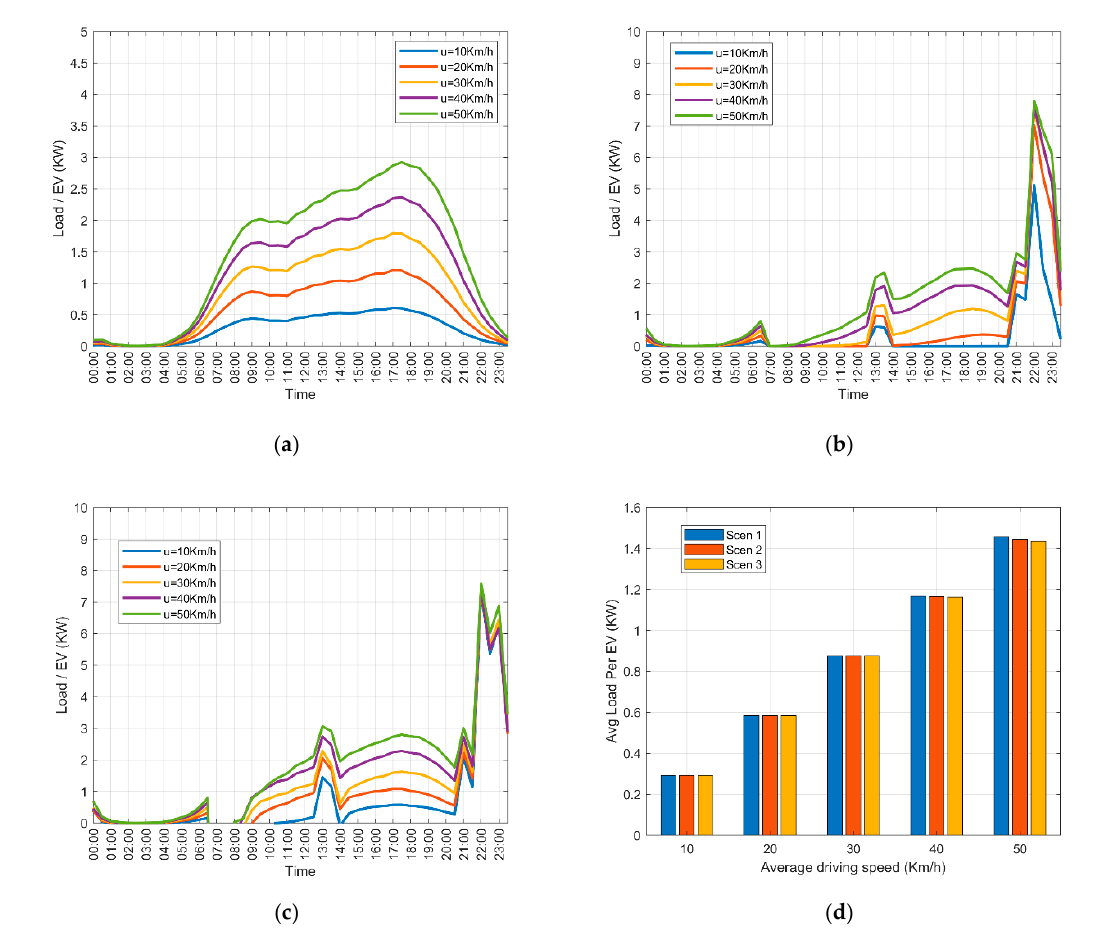
Figure 4. Additional load per EV; ( a ) Scenario 1; ( b ) Scenario 2; ( c ) Scenario 3; ( d ) additional load per EV due to the EVs’ operation averaged over 24 h for the three scenarios